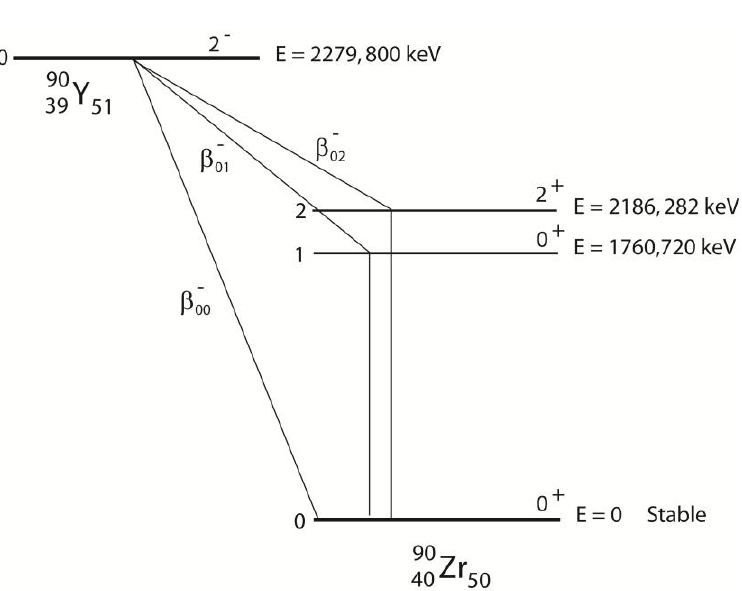
Figure 3. Decay scheme of 90